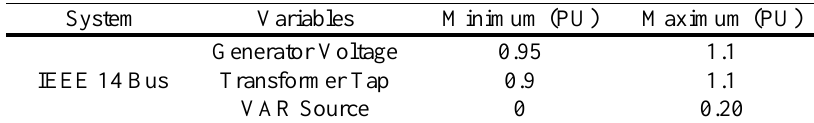
Table 1. Constraints of control variables.